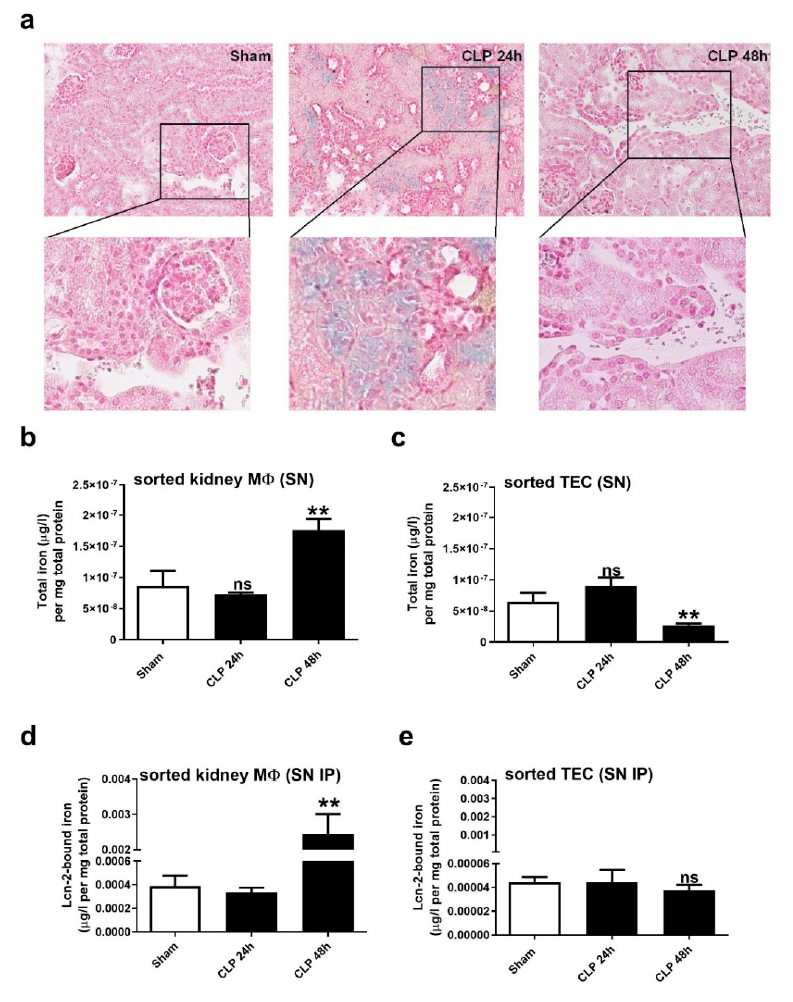
Figure 4. Iron distribution in renal tissue during CLP-induced sepsis. ( a ) Iron accumulation in renal tissue restricted to the lumen of kidney tubules (blue colored areas) at 24 h after CLP detected by Perls’ staining. At the 48 h time-point, only brownish-stained hemosiderin deposits can be observed, which are mainly found in infiltrates. Pictures are representative for 5 animals in each group. ( b , c ) Measurements of total iron amounts in the supernatants of short-term cultivated and freshly isolated ( b ) renal M Φ and ( c ) TEC using AAS. ( d , e ) Lcn-2 was immunoprecipitated in the supernatants of short-term cultivated and freshly isolated ( d ) renal M Φ and ( e ) TEC, and Lcn-2-bound iron was quantified by AAS. For ( b – e ) n = 6 isolated primary peritoneal M Φ , TEC, and renal M Φ per group, ** p < 0.01; ( b – d ): one-way ANOVA followed by Tukey’s multiple comparison test. ( e ): Kruskal-Wallis test followed by Dunn’s post-hoc test.